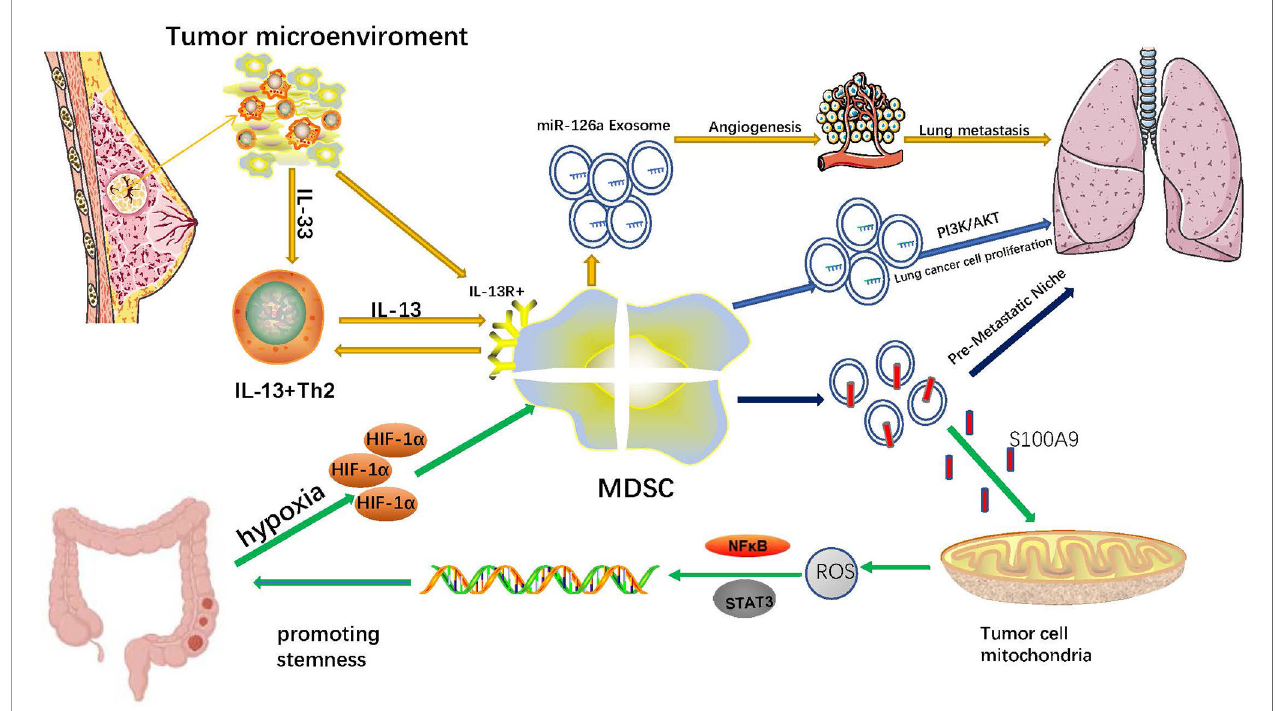
FIGURE 1 | Immunoregulator effects of MDSCs-Exos in